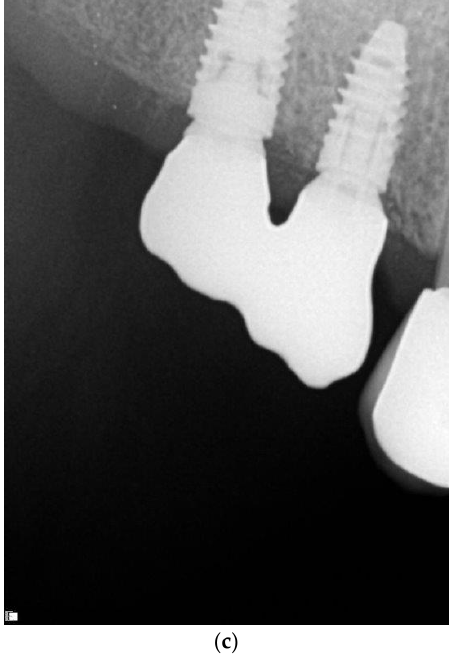
Figure 1. ( a – c ) Maxilla: ( a ) right upper first premolar and first molar replaced by implants; ( b ) im- pression copings of multiunit and healing abutments at 24 weeks; ( c ) 3-year follow-up. One of the two implants was connected to a multiunit abutment (test) and the other was connected to a healing abutment (control) (Figure 2b). The multiunit abutment (1–3 mm gingival height) was tightened at 15 N cm and covered with a cover device and was not disconnected during the rehabilitation process. The other implant was connected to a 4–6 mm healing abutment. After implant placement and connection of the HEAs or DEFs an orthoradial periapical X-ray was performed (Figures 1 and 3a). The flaps were adapted using simple interrupted absorbable 4/0 sutures (Vicryl rapid, Ethicon, Johnson and John- son, Somerville, NJ, USA).